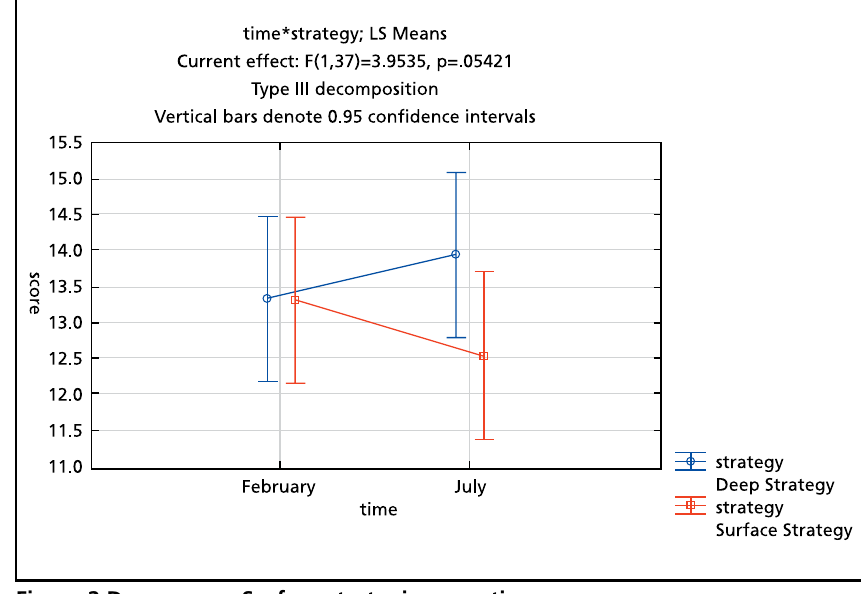
Figure 2 Deep versus surface strategies over time